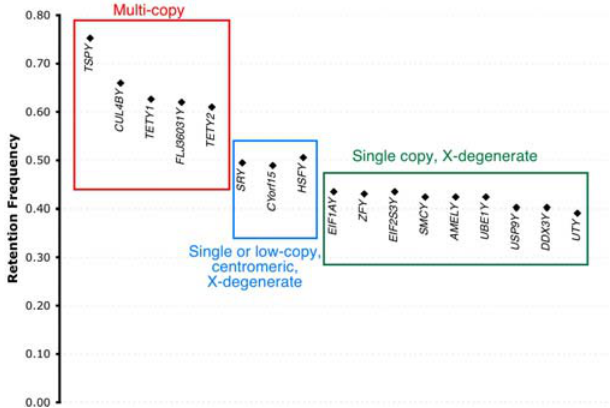
Figure 3. Retention Frequency of Different Classes of Cat Y Chromosome Genes in the Feline RH Panel The retention frequency of single copy X-degenerate genes (boxed in green) is similar to the genome-wide average of 0.39 [42–44]. Single copy X-degenerate genes close to the centromere (see Figure 5 for SRY FISH results) and potentially low–copy number genes (e.g., HSFY ), are slightly elevated (boxed in blue). The five multicopy genes (boxed in red) have considerably higher retention frequencies than the single-copy genes, confirmed by the broad Yq chromosomal distributions determined by FISH (Figure